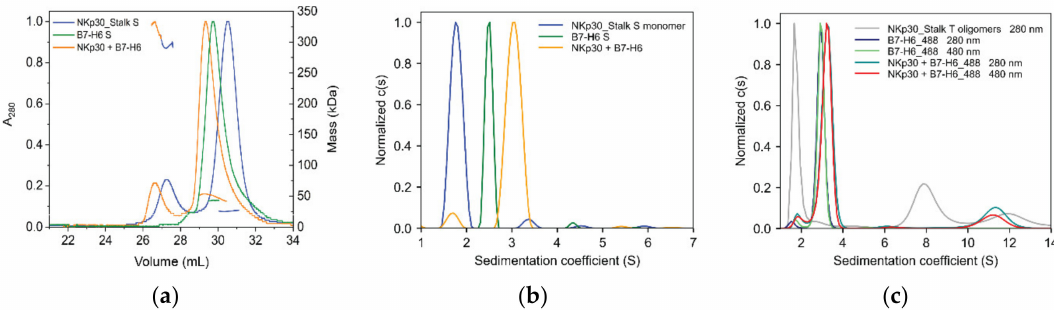
Figure 6. NKp30_Stalk oligomers cannot be saturated by B7-H6. ( a ) Normalized SEC (Size Exclusion Chromatography) elution profiles of NKp30_Stalk, B7-H6 and their equimolar mixture with MALS detection. ( b ) Sedimentation analysis of complex formation for B7-H6 and NKp30_Stalk monomeric fraction and ( c ) of NKp30_Stalk oligomeric fraction with B7-H6 labeled with ATTO488 dye performed at two wavelengths. Letters S and T denote the type of protein glycosylation (HEK293S GnTI − or HEK293T N -glycans,